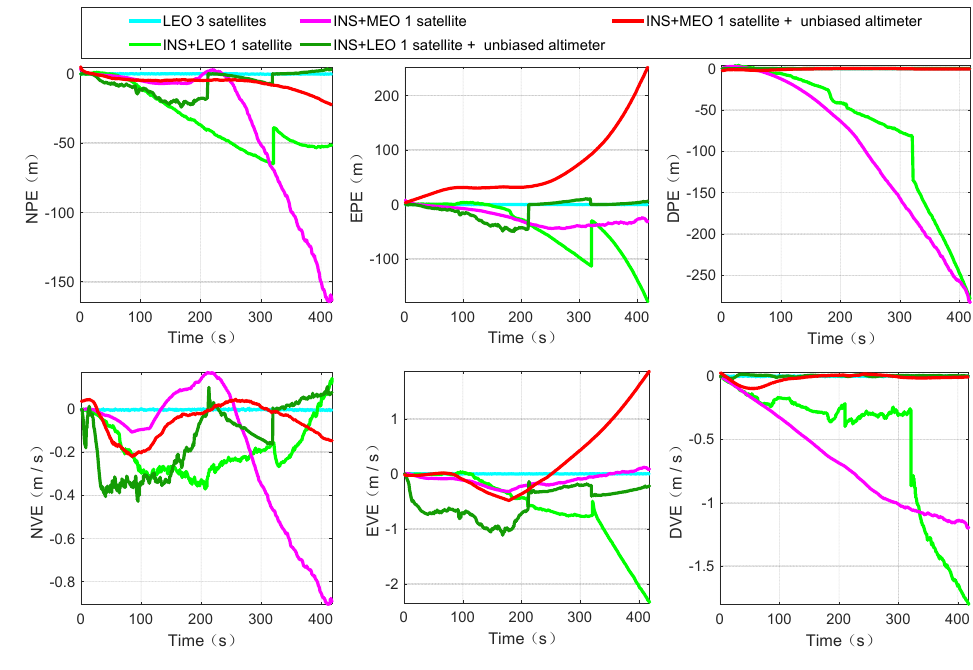
( a ) Comparison of position and velocity errors. Figure 8. Cont